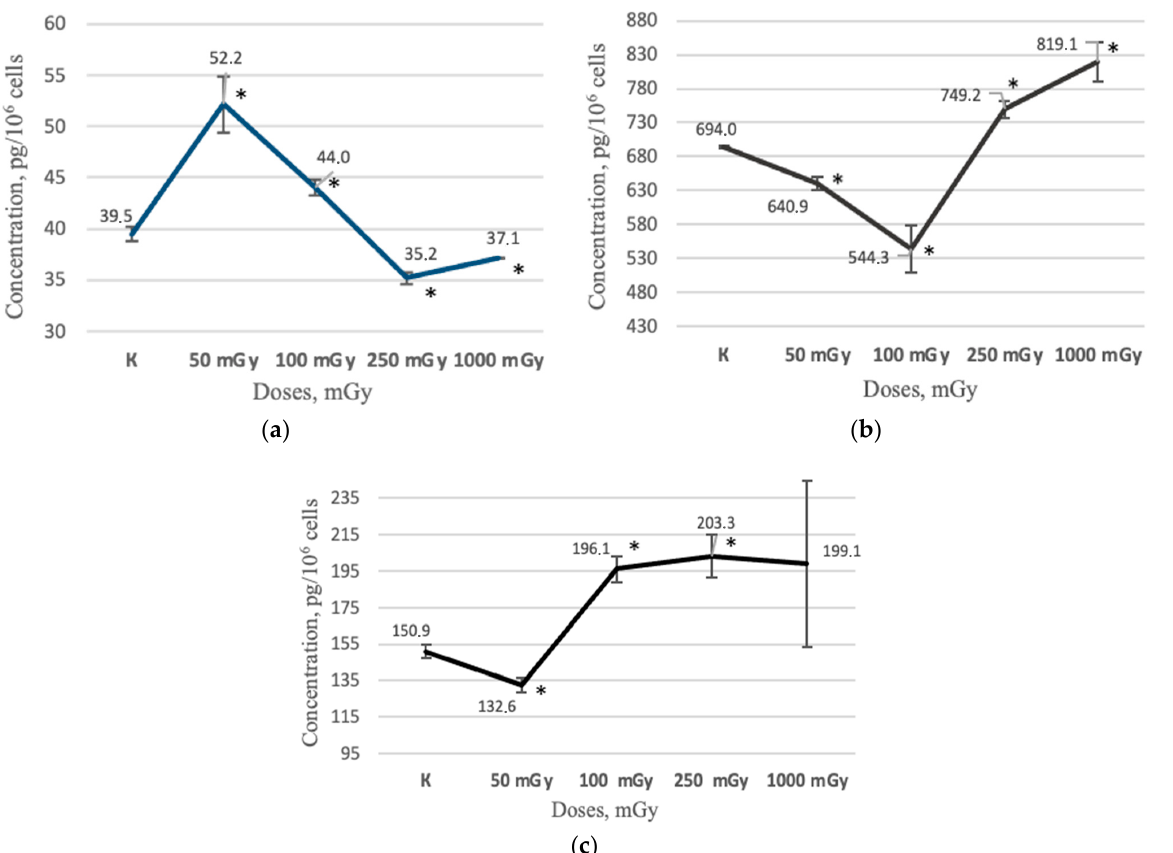
Figure 5. The results of ELISA test of conditioned mediums non-irradiated and irradiated MSCs groups (n = 6): ( a ) the IL-6 concentration in MSCs conditioned medium 48 h after irradiation; ( b ) the IL-8 concentration in MSCs conditioned medium 48 h after irradiation; ( c ) the VEGF-A concentration in MSCs conditioned medium 48 h after irradiation. * ( p < 0.05).